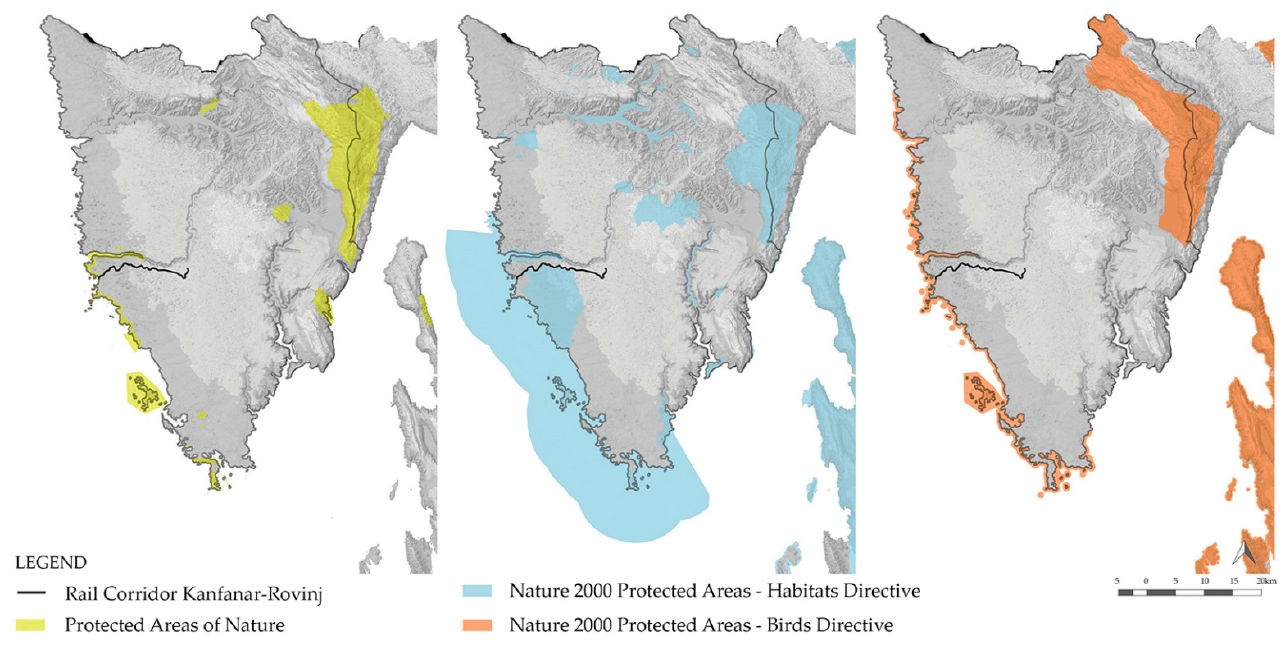
Figure 2. Protected areas of nature with Natura 2000 sites in Istria County.